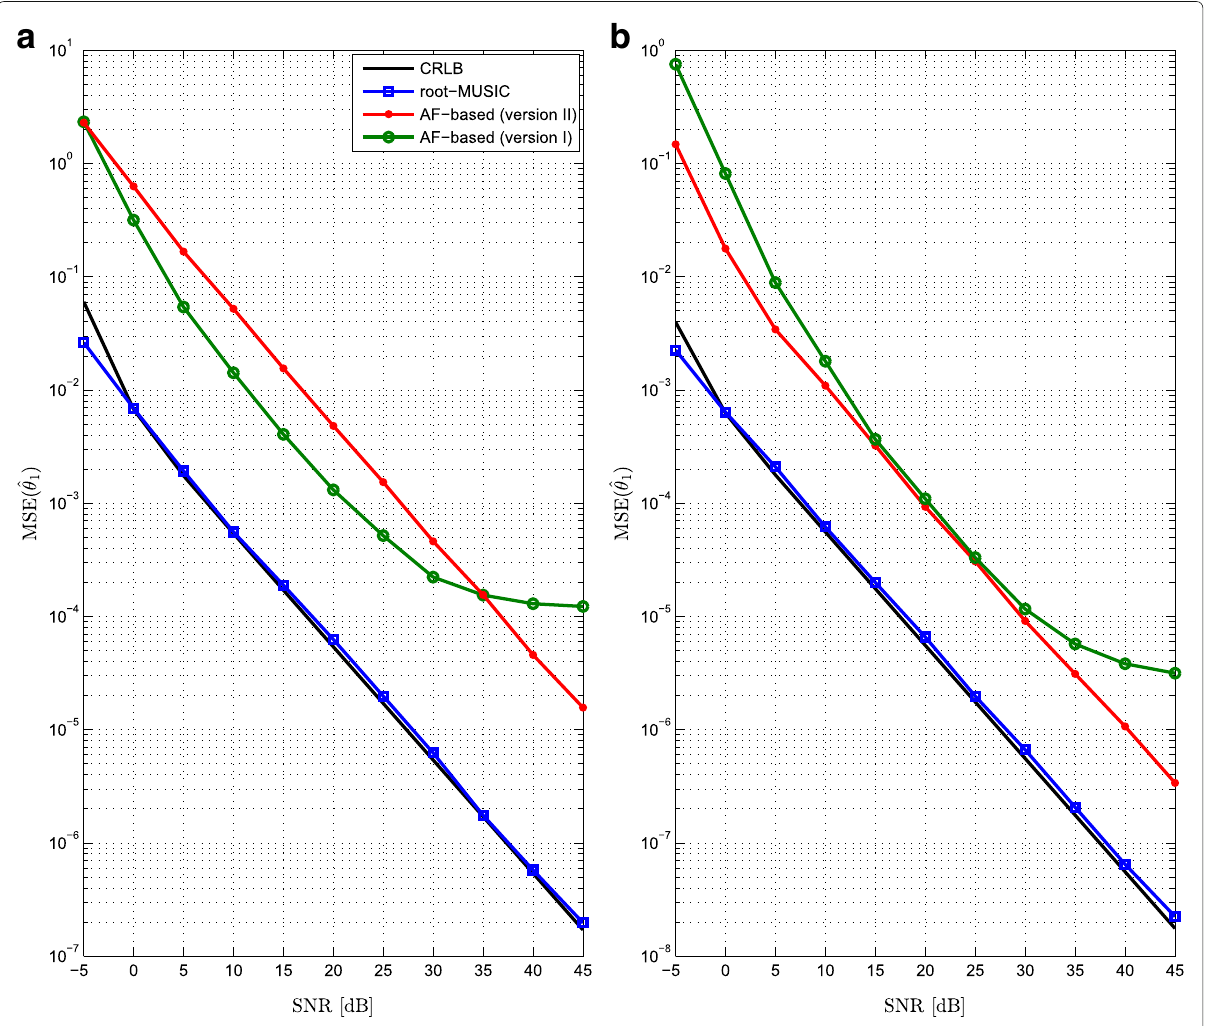
Fig. 1 MSE for the first DOA versus the SNR with K = 2 sources, N = 1000 snapshots, θ 1 = 18°, and θ 2 = 36°: ( a ) N a = 8 antenna elements and ( b ) N a = 16 antenna